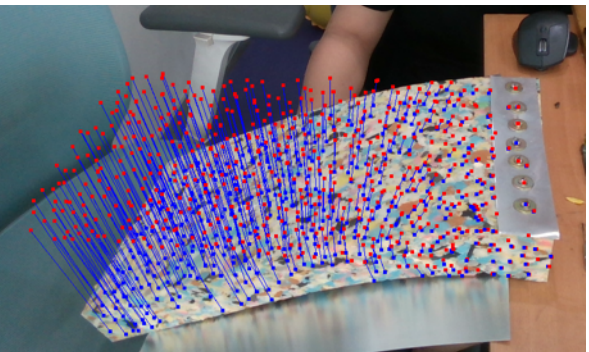
Figure 4. Feature points detected at the initial (red points) and current (blue points) frames are tracked as feature vectors (blue lines) during the tracking